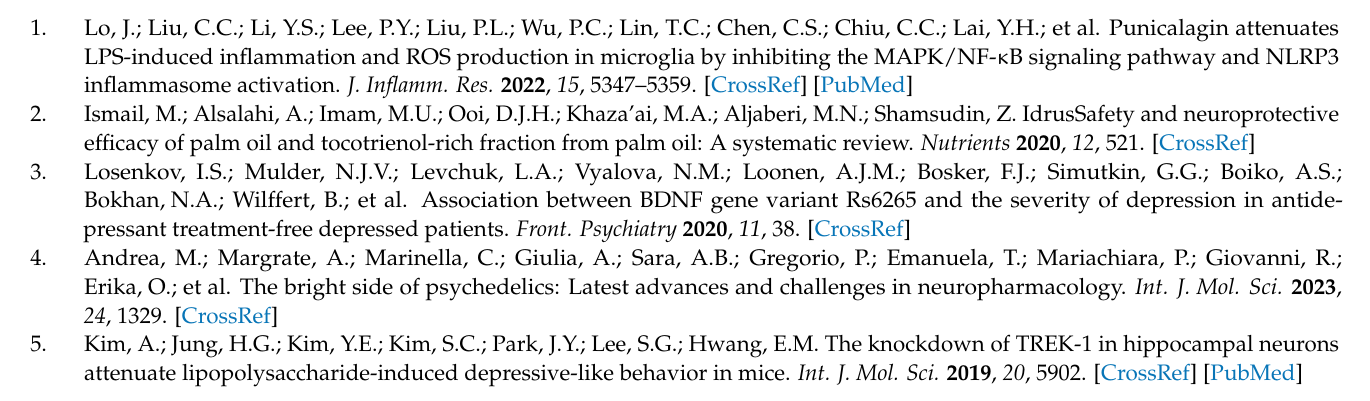
Figure S2: Part of GC-MS TIC from derivative of LTC-1 Smith degradation; Figure S3: 0riginal western blot for three repeats; Table S1: The result of LTC-1 periodate oxidation; Table S2: The result of LTC-1 partial